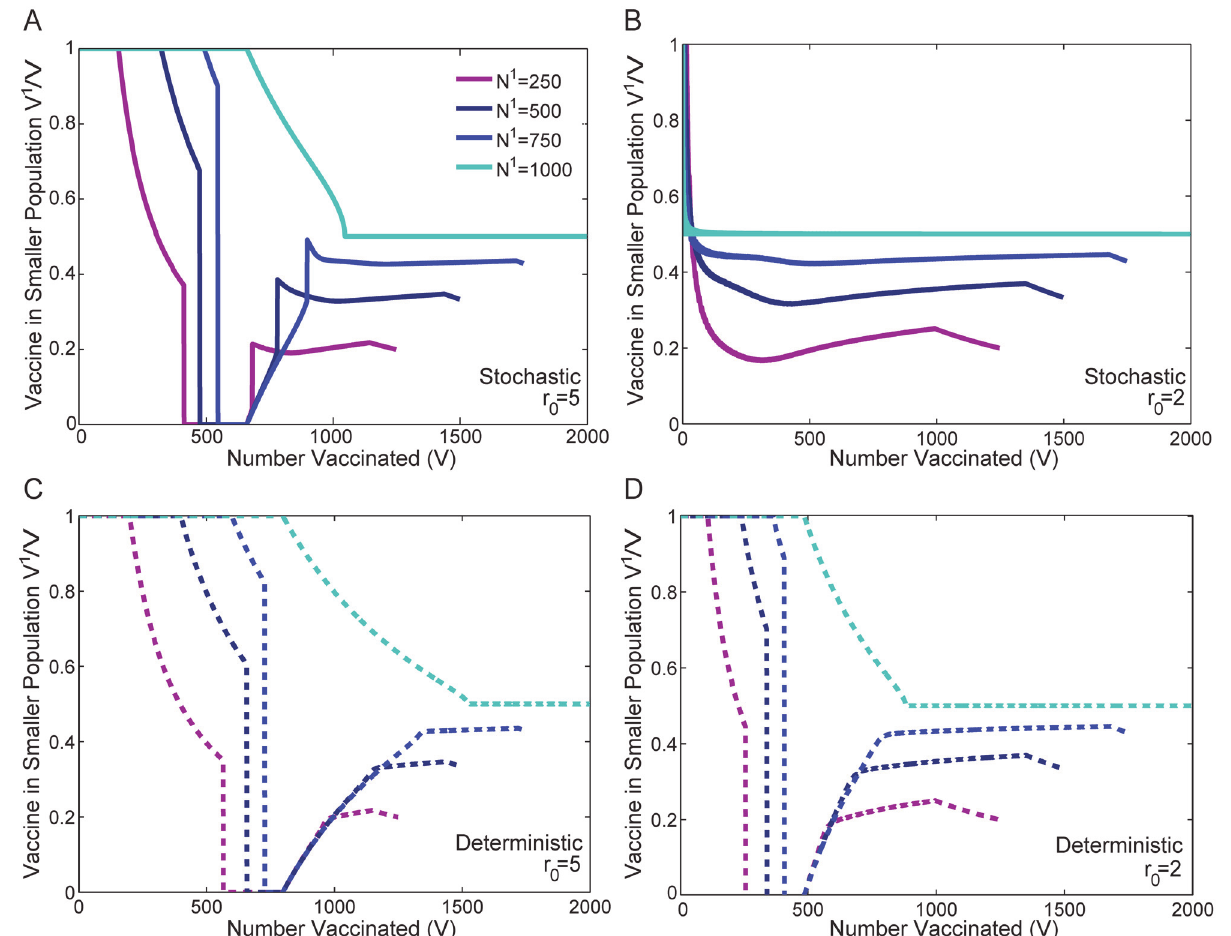
Fig 9. Impact of Variations of the Population Size Ratio on the Optimal Protocol. Figures A and B illustrate results for the stochastic model with r 0 = 5 and r 0 = 2, respectively. Figures C and D illustrate corresponding results for the deterministic model. Each curve shows the optimal fraction of the available vaccine allocated to the smaller population V 1 / V in order to minimize the average epidemic size h E i of the population as a whole. In all cases, the number of individuals in the second population N 2 = 1000 is kept constant. Different curves illustrate results as the number of individuals in the first population is varied: N 1 = 250, 500, 750, and 1000. The qualitative results obtained previously for the stochastic and deterministic protocols in Figs. 4 and 5 are preserved for changes in the ratio of population sizes, except in the case of equal population sizes N 1 / N 2 = 1, in which case there is no broken symmetry in the population ¼ I 2 ¼ sizes. All populations are initialized with a single infected individual I 1 0 0